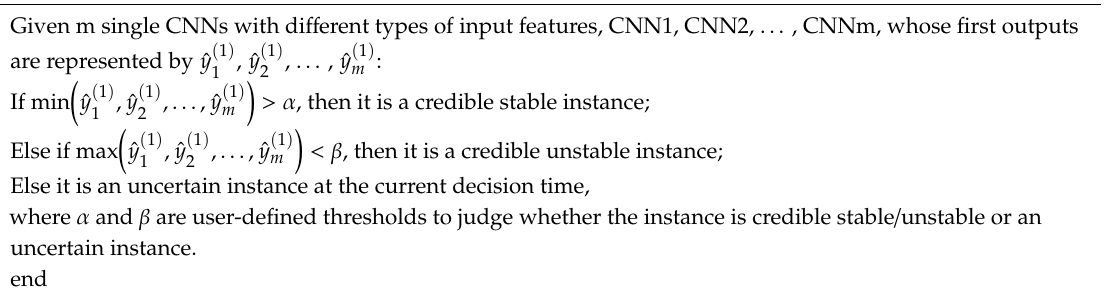
Algorithm 1: Integrated decision-making rule for CNN-based ensemble classification Given m single CNNs with di ff erent types of input features, CNN1, CNN2, ... , CNNm, whose first outputs ( 1 ) ( 1 ) ( 1 ) are represented by ˆ y , ˆ y , ... , ˆ y m : 2 1 (cid:18) (cid:19) ( 1 ) ( 1 ) ( 1 ) > α , then it is a credible stable ˆ y If min , ˆ y , ... , ˆ y m 2 1